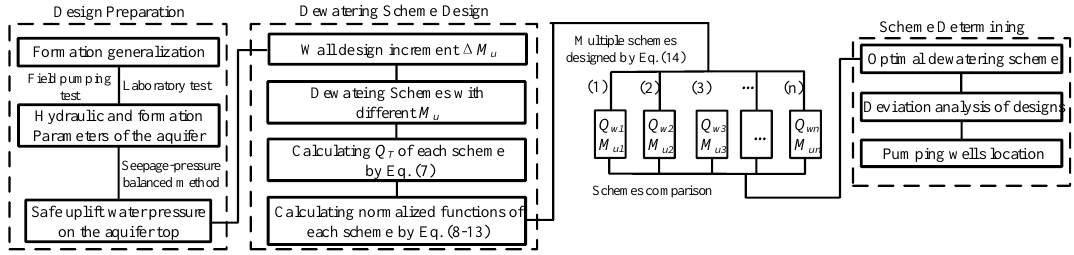
Figure 9. Dewatering scheme design method with partial penetrating curtains.